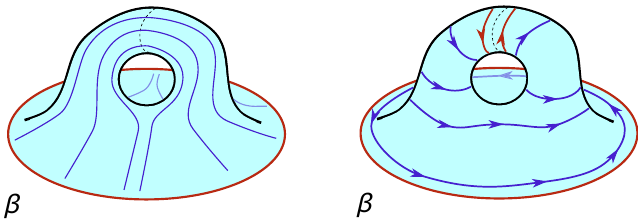
Figure 15 . An attempt to define a family of oriented Cauchy surfaces (left) or equivalently a global Killing vector field that asymptotes the boundary time flow (right) on a handlebody. This is impossible: we obtain a contradiction on the dotted line (right).